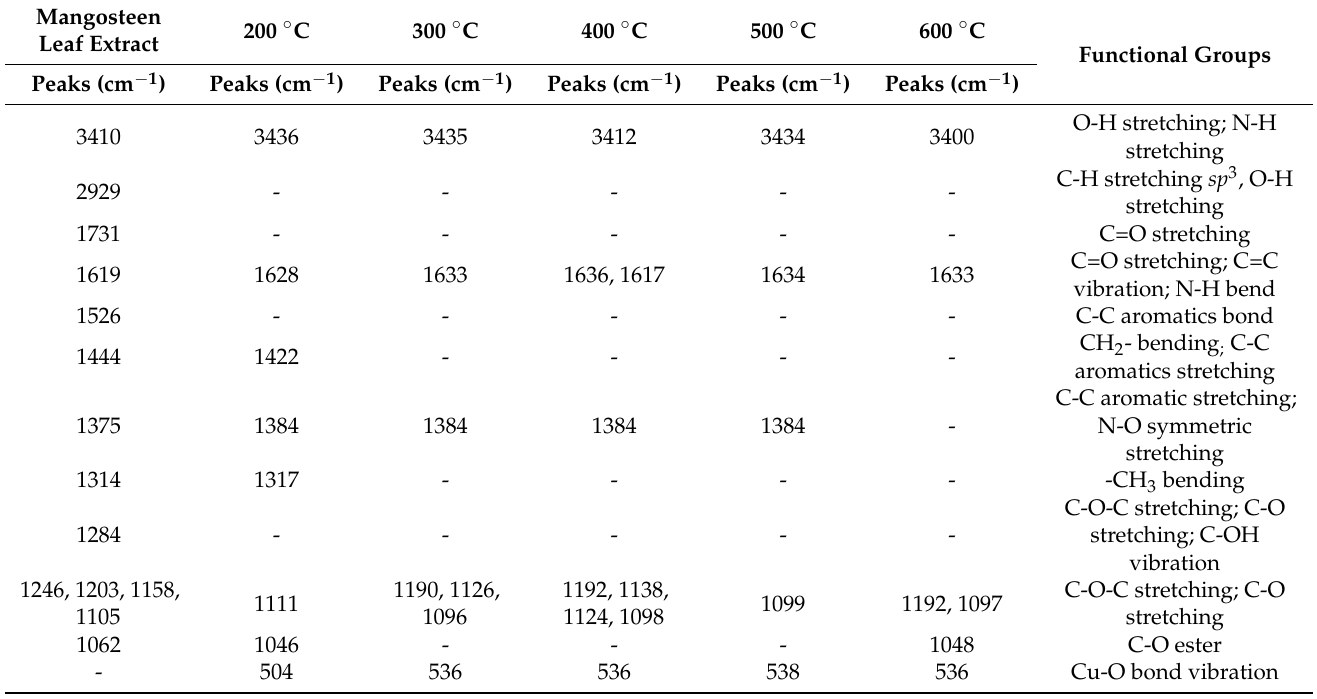
Table 2. FTIR peak assignment of CuO nanostructures calcinated at different temperatures and mangosteen leaf